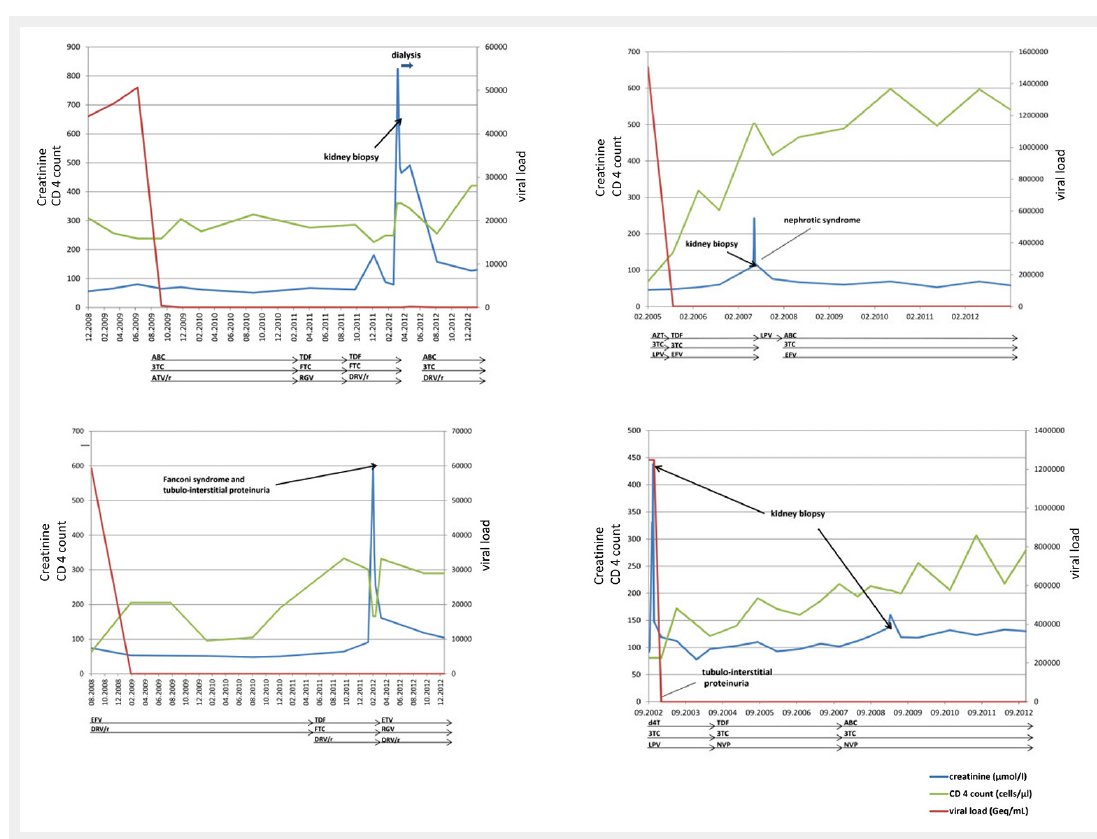
The individual courses of patients 2, 4, 9 and 10. Dialysis, the presence of tubulointerstitial proteinuria and kidney biopsies are indicated by arrows. 3TC = lamivudine; ABC = abacavir; EVF = efavirenz; ATV/ = atazanavir/ritonavir; d4T = stavudin; DRV/r = darunavir/ritonavir; FTC = emtricitabine = LPV/r, lopinavir/ritonavir = NVP, nevirapine; RGV = raltegravir; TDF = tenofovir disoproxil